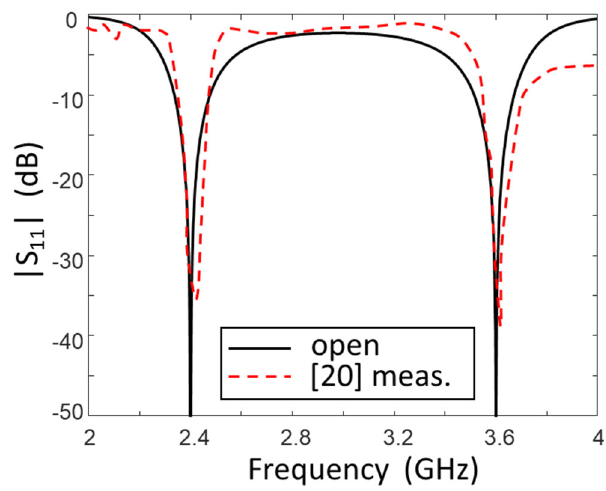
Figure 4. Comparison between the reflection coefficient obtained with two-section networks (con- tinuous and dash-dotted black lines) and those reported in the literature (dashed red line) for the case [20] in Table 1.